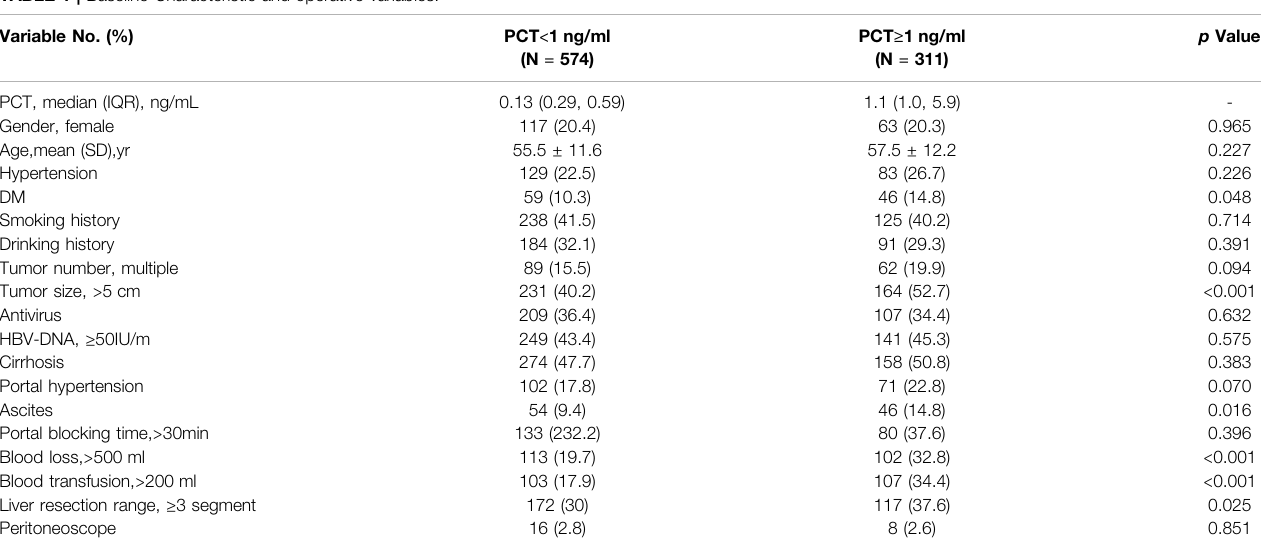
TABLE 1 | Baseline Characteristic and operative